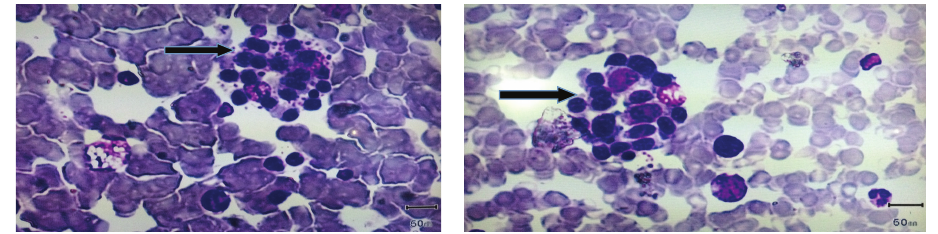
Figure 1: Two bone marrow biopsy slides of patient showing histiocyte surrounded by erythroblasts